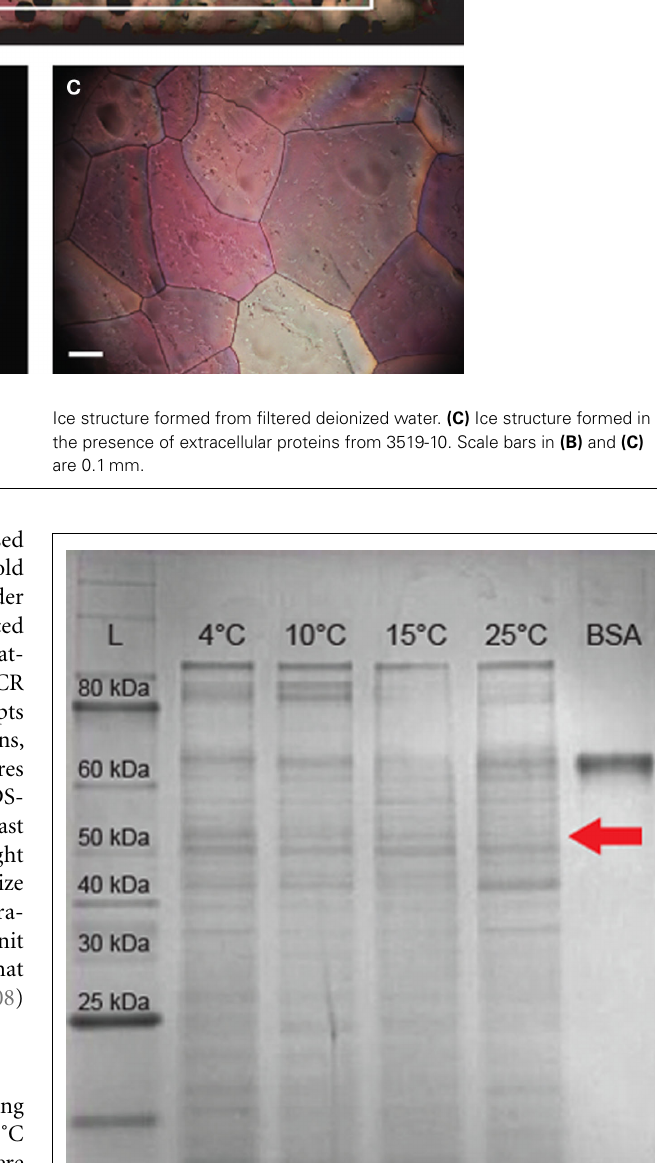
FIGURE 4 | Sodium dodecyl sulfate-polyacrylamide gel electrophoresis of extracellular proteins from 3519-10. Lane 1 contains a 10- to 250-kDa protein ladder. Lanes 2–5 contain 10 μ g total extracellular protein harvested from cultures grown at 4, 10, 15, and 25˚C respectively. Lane 6 contains 10 μ g of BSA (66kDa).The arrow indicates the expected migration of the IBP based on the predicted size of 54kDa.